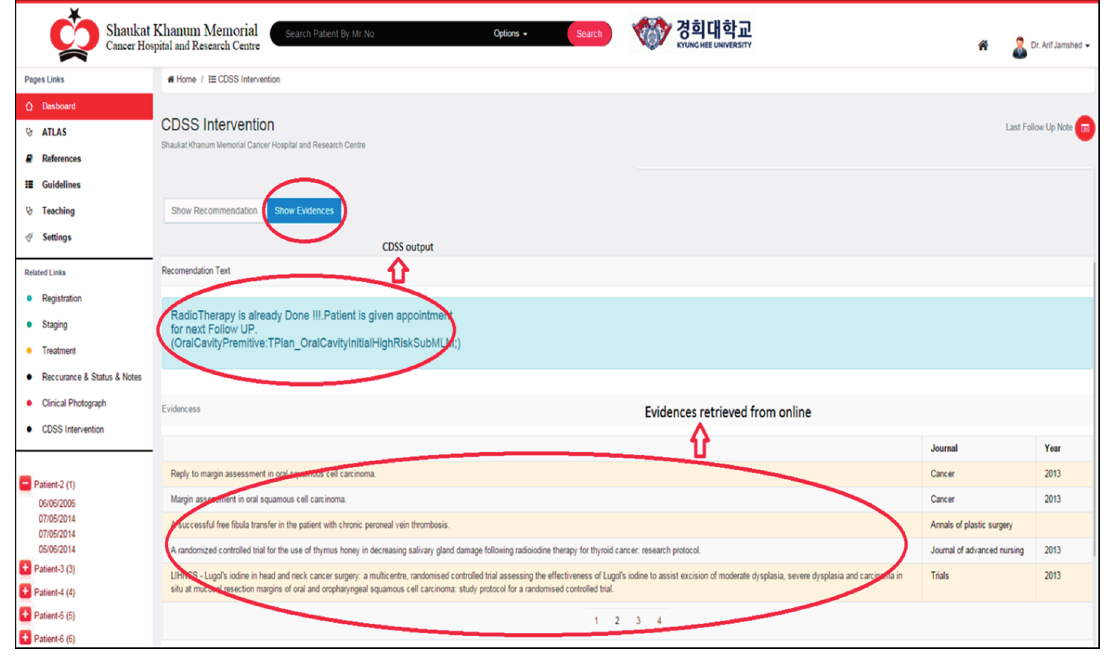
Figure 8. Query result integration with Smart CDSS through